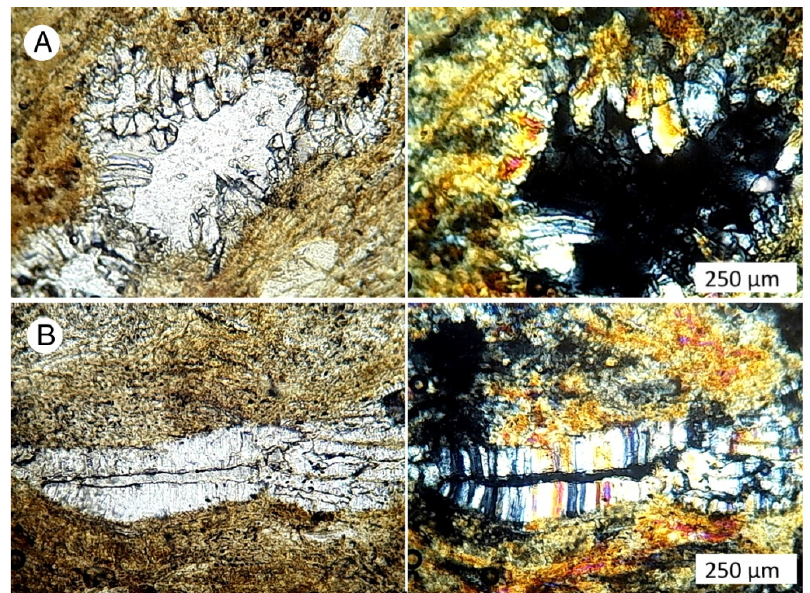
Figure 5. Thin-section images of fossil wood from Tak fossil forest showing vessels lined with quartz crystals, with the central area remaining open. For each pair, the image on the left is illuminated with ordinary transmitted light; the image on right was made with cross-polarized light. ( A ) Specimen from log BT-3. ( B ) Specimen 4c, collected from log BT-4.